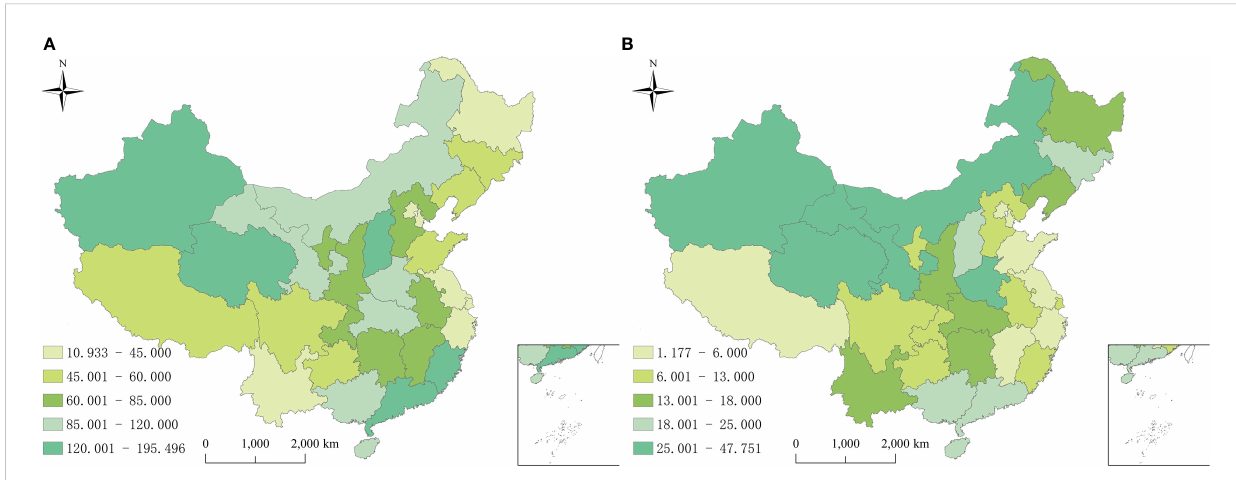
FIGURE 2 Annual average incidence rates of reported hepatitis B and C by province in China from 2010 to 2018. (A) Hepatitis B; (B) Hepatitis